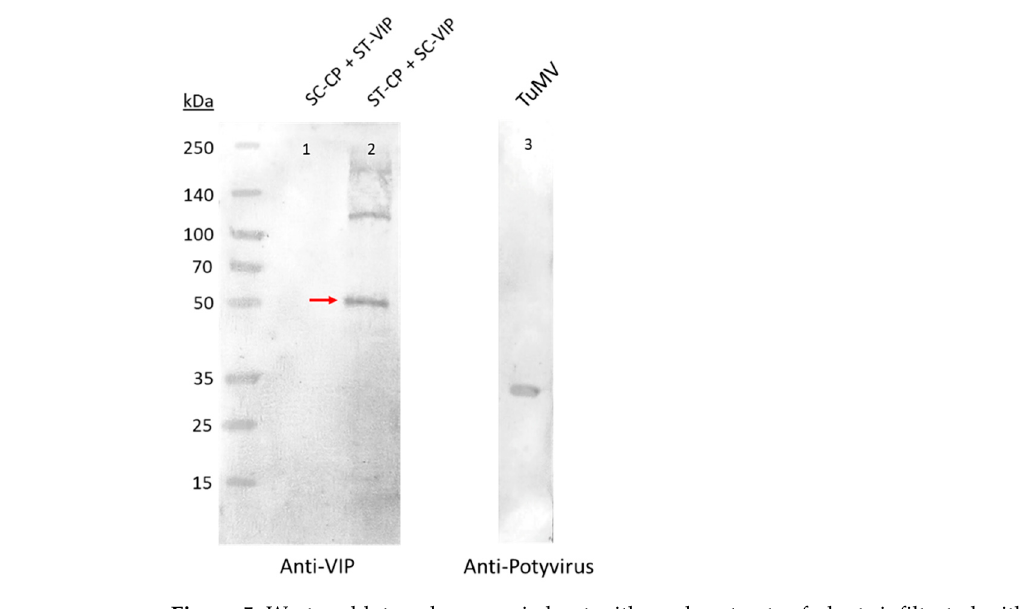
Figure 5. Western blot analyses carried out with crude extracts of plants infiltrated with the different constructs of TuMV VLPs-VIP using the SpyTag/SpyCatcher conjugation technology. The red arrow points to the expected band if SpyTag and SpyCatcher are bound (51.8 kDa). ST: SpyTag; SC: SpyCatcher; CP: TuMV capsid protein; VIP: vasoactive intestinal peptide.